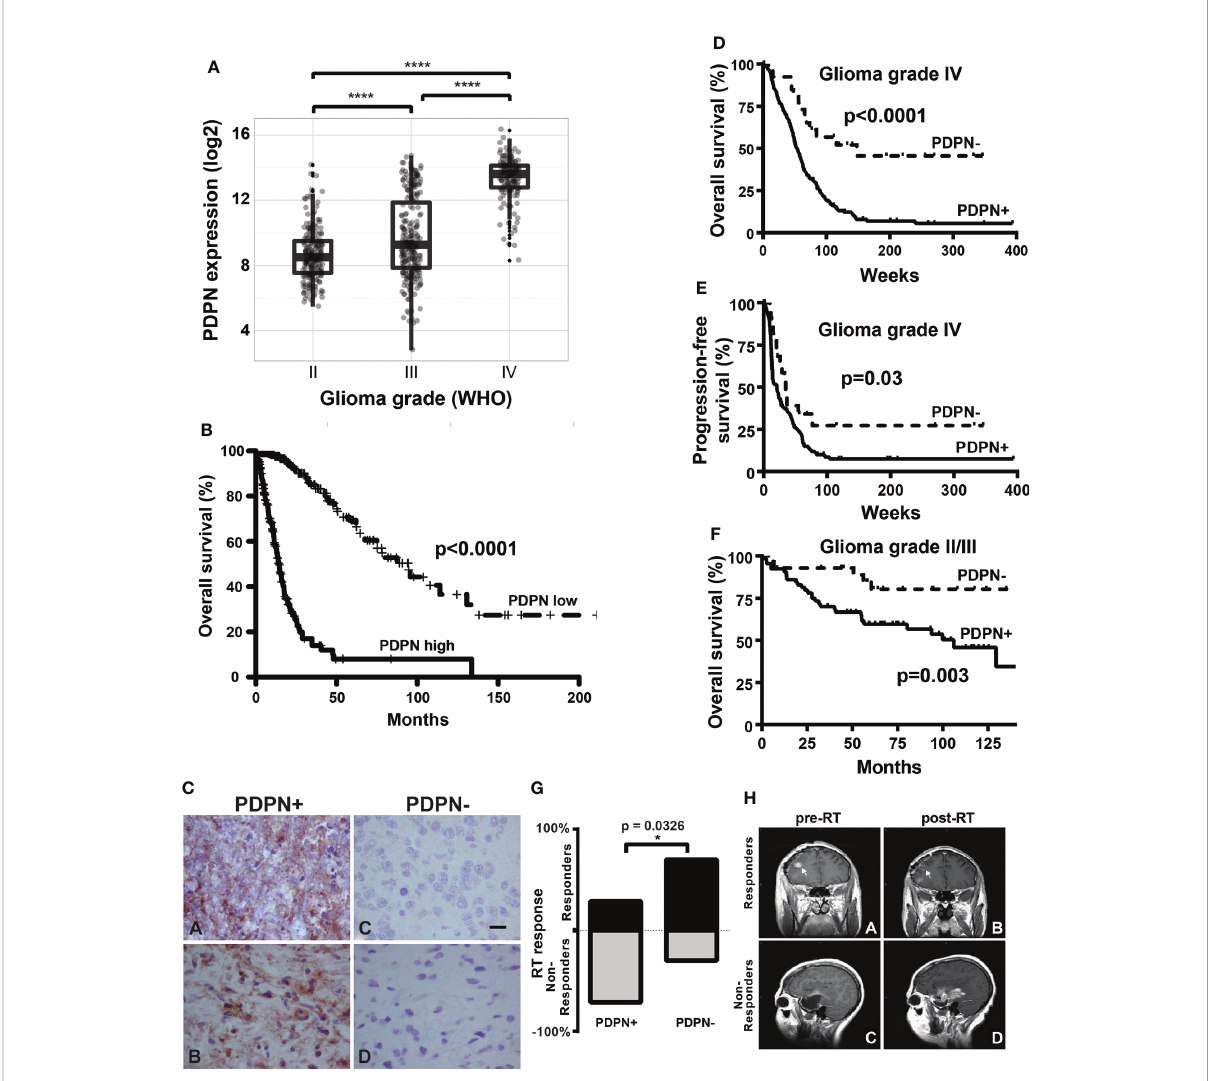
FIGURE 1 PDPN is expressed in in fi ltrating gliomas and negatively correlates with survival. (A) Boxplots show increasing PDPN expression across increasing glioma grades in TCGA (n=601, ****p<0.0001). (B) Kaplan – Meier curves show that PDPN mRNA expression inversely correlates with OS across glioma grades in TCGA cohorts. Median OS for patients with PDPN-high and PDPN-low tumors was 14.4 and 94.5 months, respectively (n=601, p<0.0001). (C) Representative IHC examples of PDPN expression in FFPE tumor tissue using the M2A antibody in tumors. Subpanels (A, B) shows intense cytoplasmic staining in nearly all cells, while expression is undetectable in tumors in subpanels (C, D) . (D) Kaplan – Meier curves show that PDPN protein expression inversely correlates with OS among GBM WHO grade IV patients. Median OS for PDPN+ and PDPN − groups was 53.4 and 148.1 weeks, respectively (n=206, p<0.0001). IHC KM curves are shown as solid (PDPN+) and dashed (PDPN − ) lines. (E) Kaplan – Meier curves show that PDPN protein expression inversely correlates with PFS among GBM WHO grade IV patients. Median PFS for PDPN+ and PDPN − groups were 21.0 and 34.6 weeks, respectively (n=206, p=0.03). (F) Kaplan – Meier curves show that PDPN protein expression inversely correlates with OS among grade II/III diffuse astrocytoma patients (n=93, p=0.003). (G) Radiation response is correlated with PDPN expression (n=16, *p=0.0326). (H) MRI examples of a radiation responder (A, B) and non-responder (C, D) , pre- and post-radiation